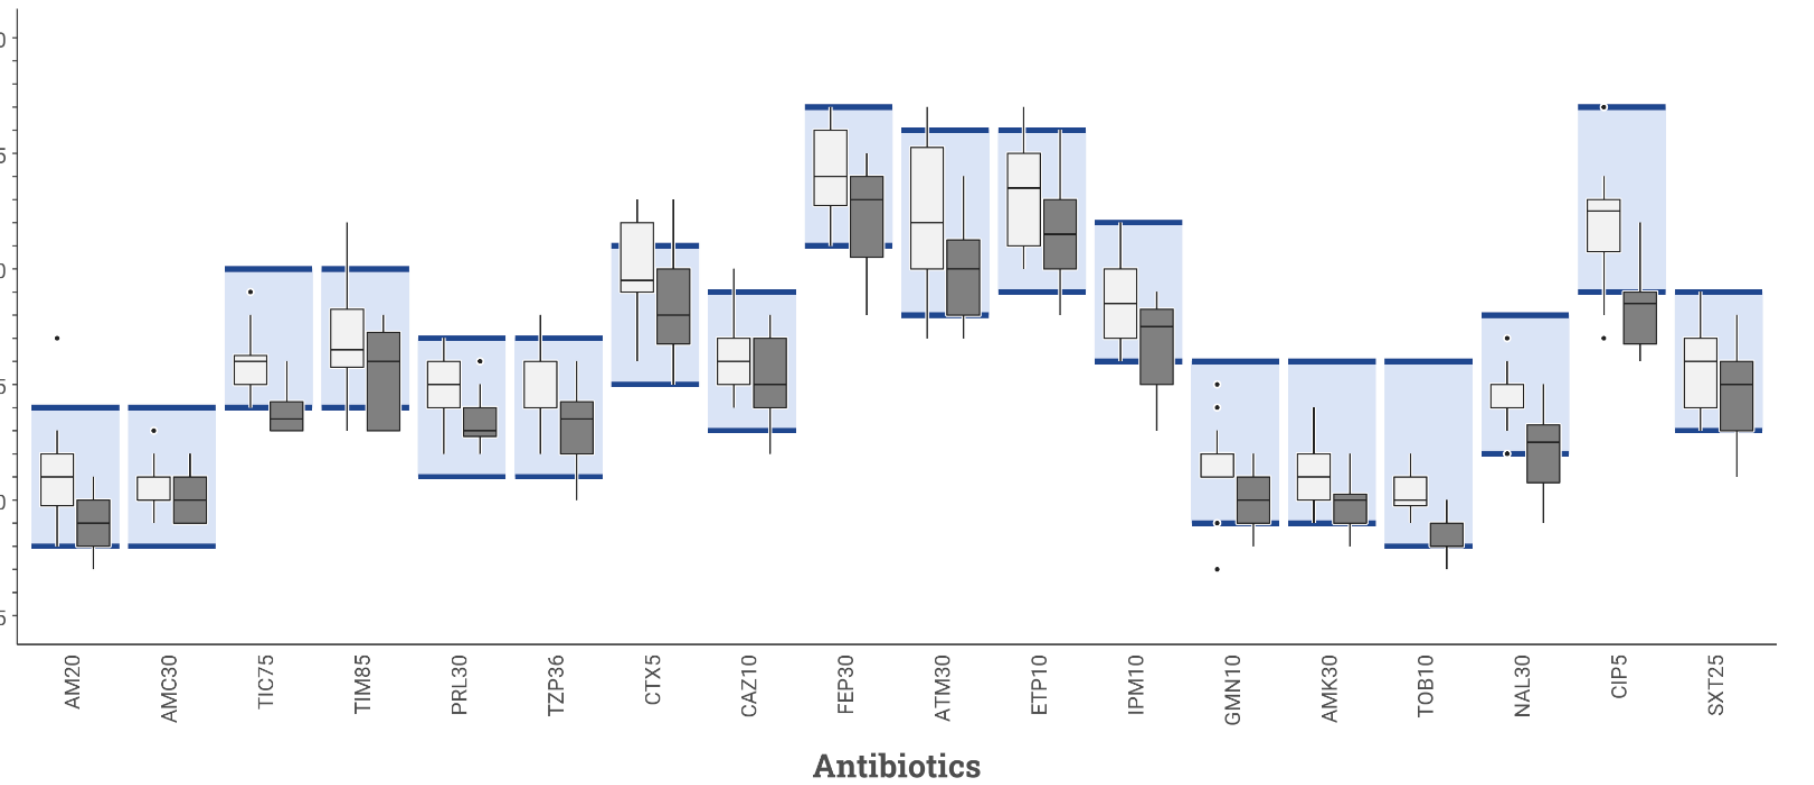
Figure 2. Inhibition diameters for various antibiotics tested on MHR-SIR agar of E. coli strain ATCC 25922 obtained during repeatability study comparing 2 inoculation protocols: BSAC (white box-plot) vs. CASFM-EUCAST (black box-plot) recommendations. The boxplot shows the 25th and 75th percentile with a horizontal bar indicating the median. Whiskers represent the 5th and 95th percentile. Extreme values are shown with dots. The colored rectangle indicates the acceptable limit values for each antibiotic according to the CASFM 2019 v2 recommendations. AM20 = Amoxicillin 20 µg, AMC30 = Amoxicillin-clavulanic acid 30 µg, TIC75 = Ticarcillin 75 µg, TIM85 = Ticarcillin-clavulanic acid 85 µg, PRL30 = Piperacillin 30 µg, TPZ36 = Piperacillin-tazobactam 36 µg, CTX5 = Cefotaxime 5 µg, CAZ10 = Ceftazidime 10 µg, FEP30 = Cefepime 30 µg, ATM30 = Aztreonam 30 µg, ETP10 = Ertapenem 10 µg, IPM10 = Imipenem 10 µg, GN10 = Gentamicin 10 µg, AK30 = Amikacin 30 µg, TOB10 = Tobramycin 10 µg, NA30 = Nalidixic acid 30 µg, CIP5 = Ciprofloxacin 5 µg, SXT25 = Trimethoprim + sulfamethoxazole 25 µg.